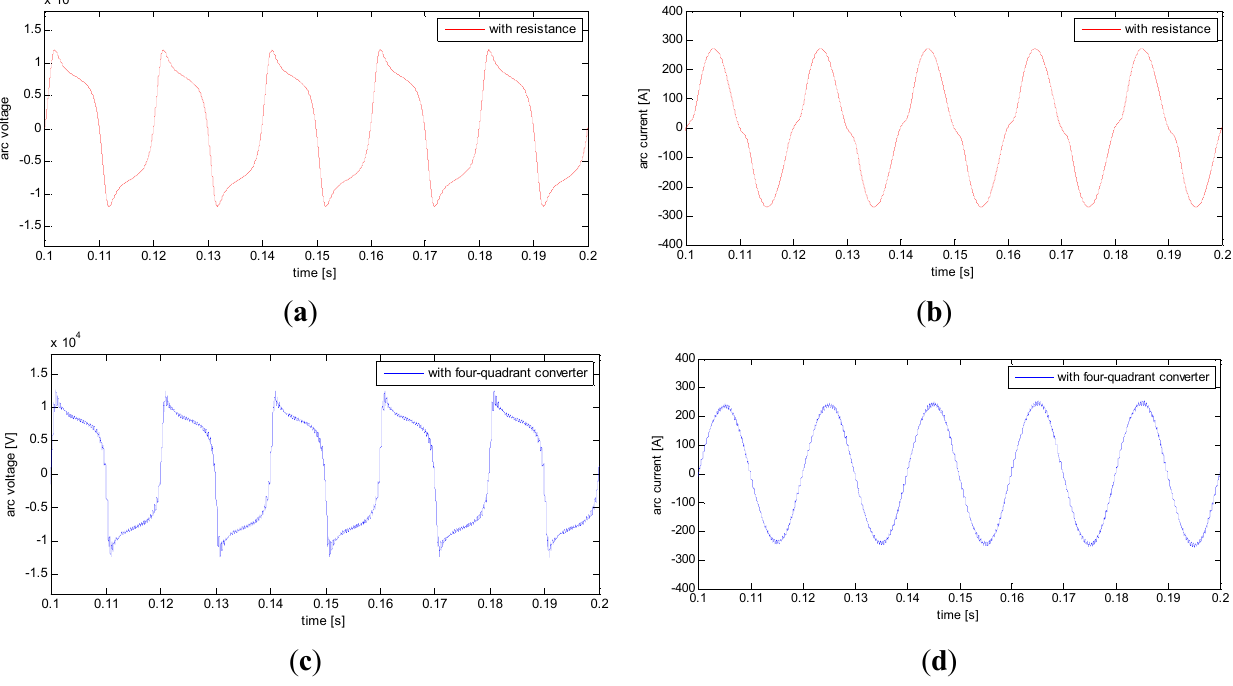
Figure 8. ( a ) Arc voltage with resistance load; ( b ) Arc current with resistance load; ( c ) Arc voltage with four-quadrant converter load; and ( d ) Arc current with four-quadrant converter